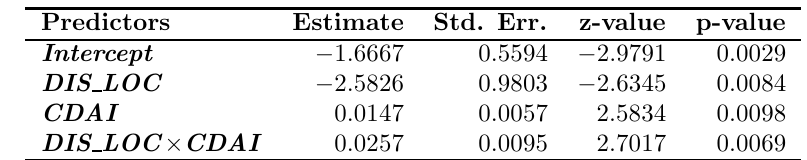
Estimation results for the FC